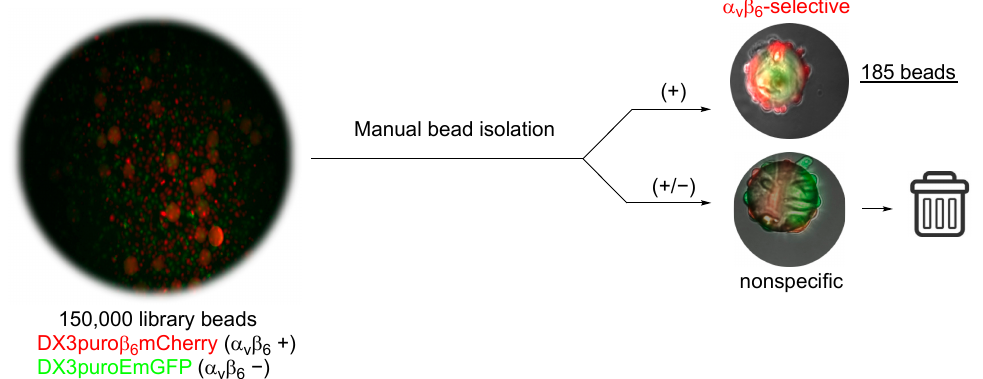
Figure 1. Schematic representation of the On-Bead Two-Color (OBTC) cell screening utilizing fluorescent DX3puro β 6 mCherry ( α v β 6 + , red) and DX3puroEmGFP ( α v β 6 − , green)